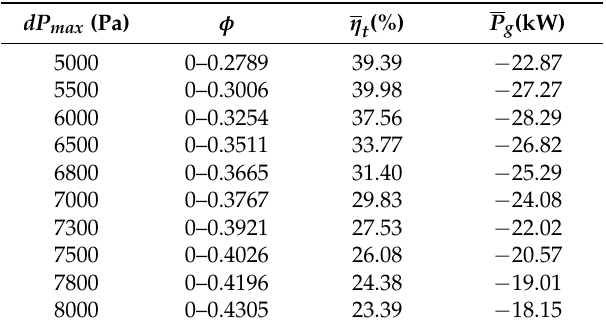
Table 2. Performance of uncontrolled system ( R ext = 0).